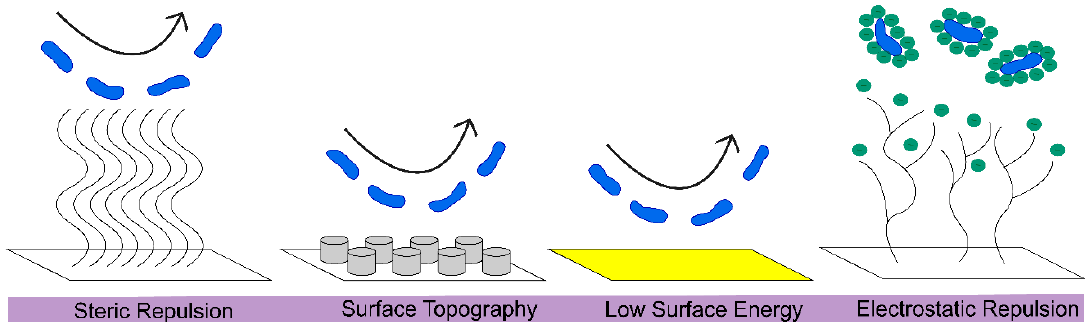
Figure 3. Antifouling surfaces repel microorganisms through steric repulsion, surface topography, low surface energy, or electrostatic repulsion.